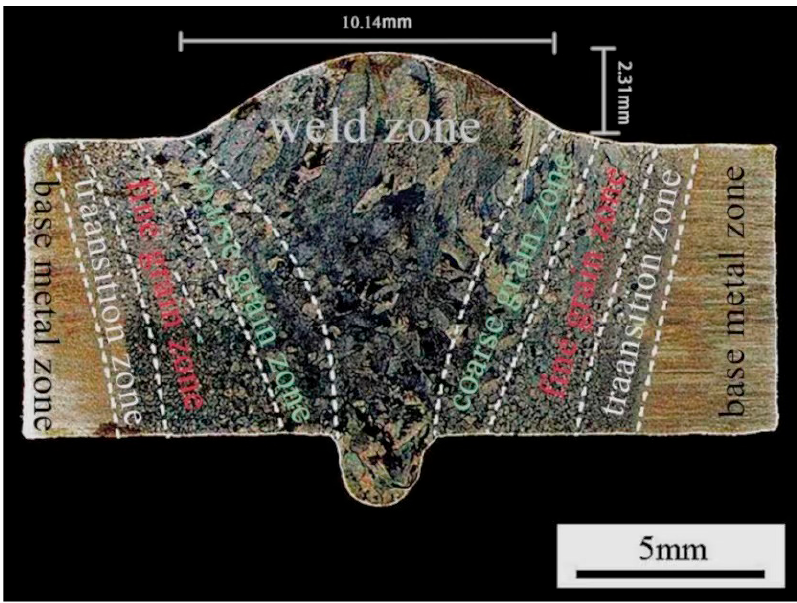
Figure 7. Sectional appearance of a weld joint containing the weld zone, heat-affected coarse grain zone, heat-affected fine grain zone, transition zone, and base metal zone.